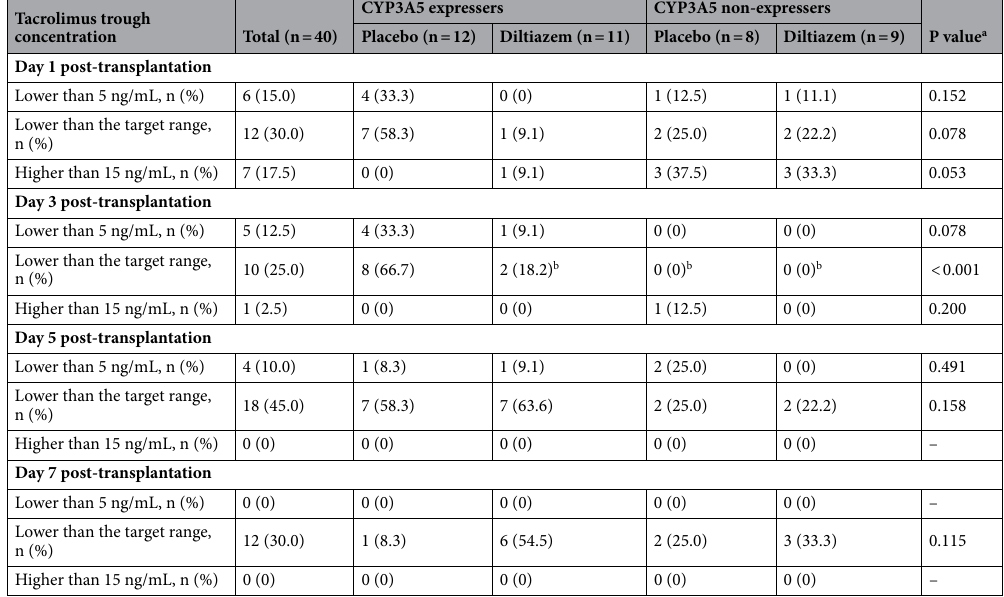
CYP3A5 expressers CYP3A5